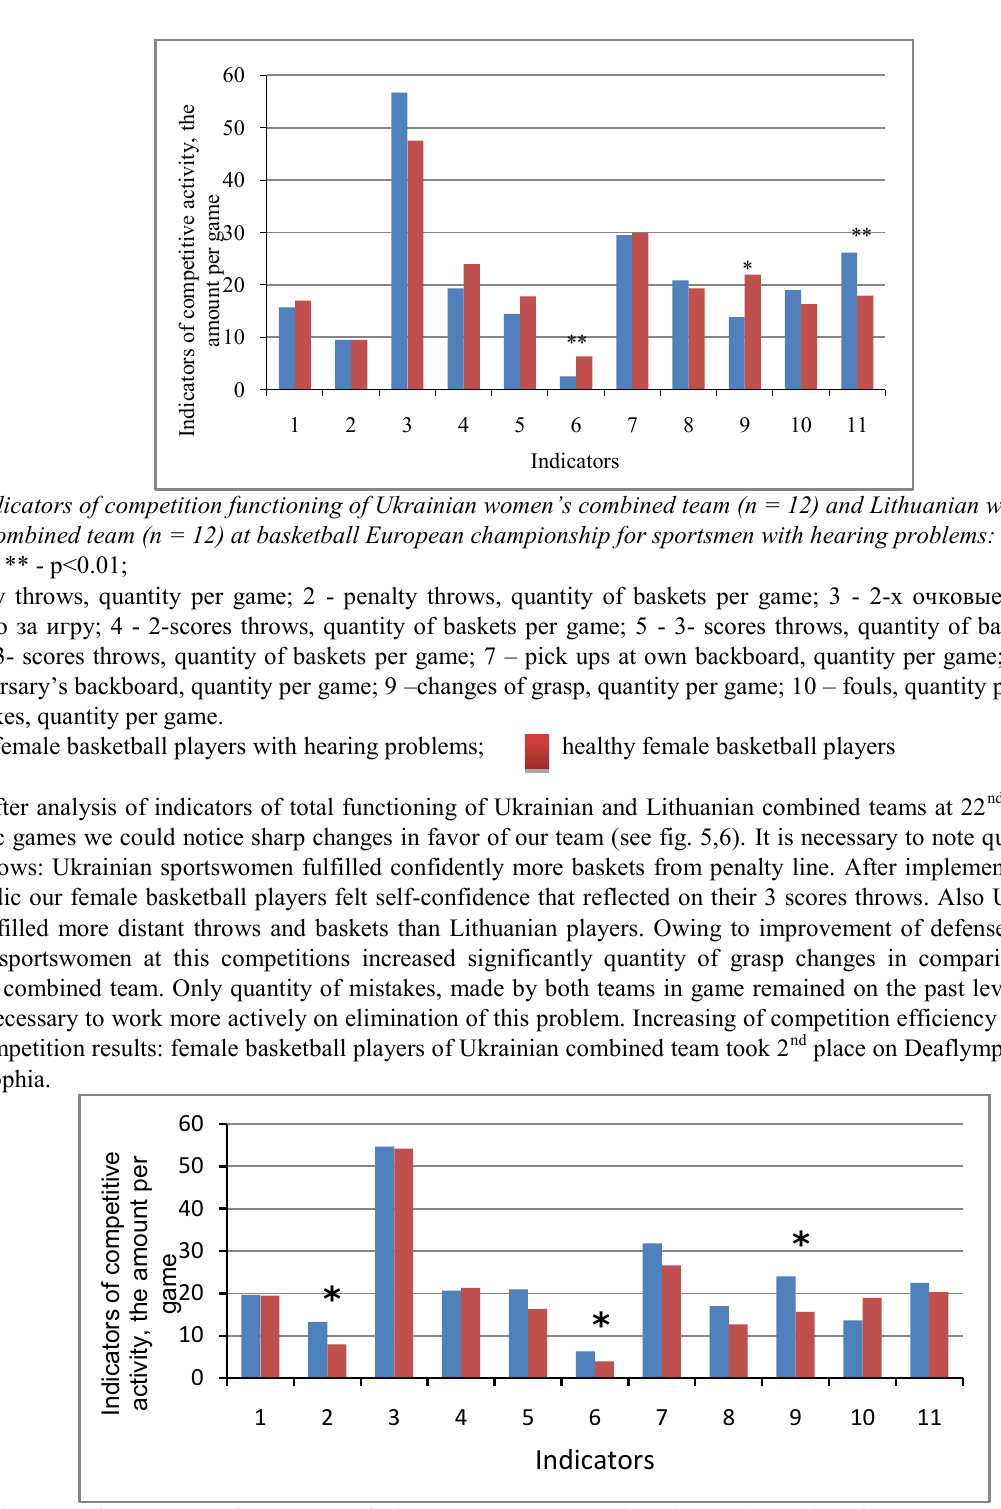
Fig.5. Indicators of competition functioning of Ukrainian women’s combined team (n = 12) and Lithuanian women’s combined team (n = 12) at summer Deaflympic games for sportsmen with hearing problems: * - р<0.05; ** -